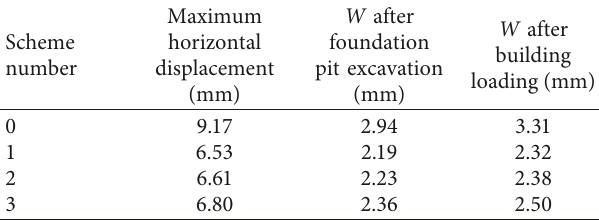
W is the horizontal displacement difference between the tunnel structure roof and the